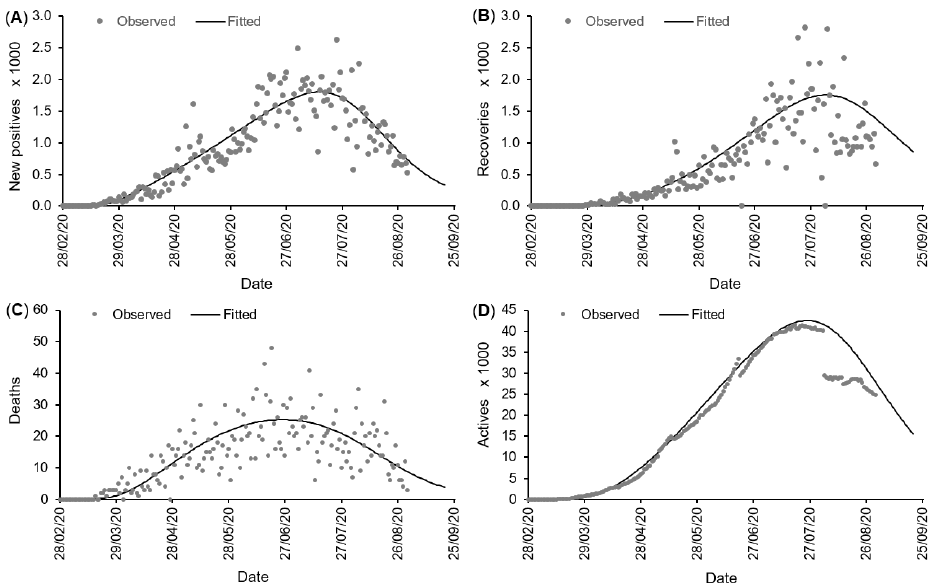
Figure 2. Records of new positive cases ˙ C t ( A ), daily recoveries α t Q t , ( B ), daily deaths (cid:101) t Q t ( C ) and known actives cases (quarantined at home/hospital) Q t ( D ) in COVID-19 daily case reporting data from West Africa (28 February to 31 August 2020). The fitted curves are based on a combination of an early exponential growth model and a generic growth model with log-normal error structure for the daily new positive cases ˙ C t , two logistic regression models for the probabilities of recovery ( α t ) and death ( (cid:101) t ) and the combination of ˙ C t , α t and (cid:101) t (using (13)) for actives Q t . Two outlying data points (6006 recoveries on 20 June 2020 and 11,468 recoveries on 4 August 2020) were removed from the graph ( B ) for a better visualization. Table 6. Estimate, standard error ( SE ) and 95% confidence interval ( CI 95% ) for some quantities using the West African COVID-19 data from 28 February to 31 August 2020.